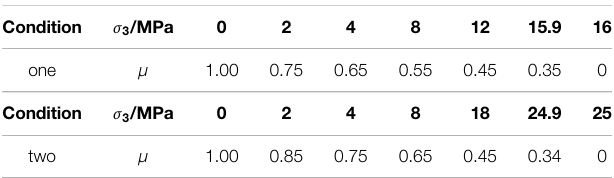
TABLE 4 | Scaling factor changes with the minimum principal